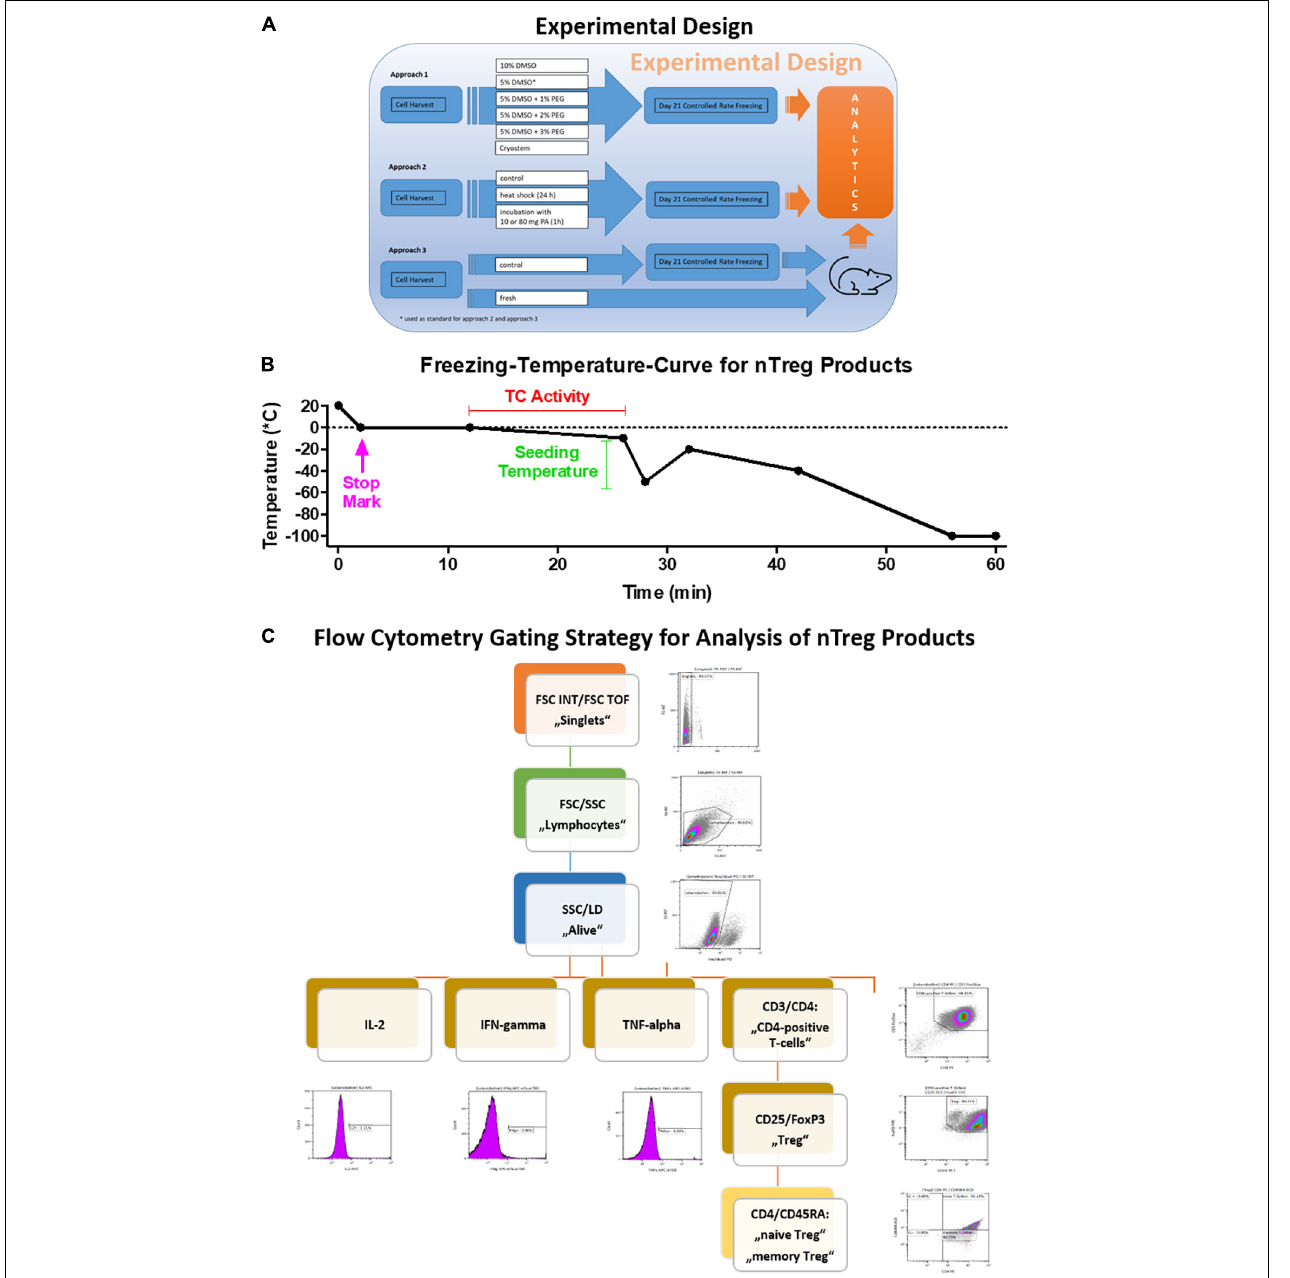
FIGURE 1 | Freezing curve and flow cytometry gating strategy. (A) Experimental design and (B) Programmed freezing curve as shown in Tables 1 , 2 [Stage Temp. ( ◦ C) Duration Heating Stop Seeding Temp. control] and (C) Gating scheme used for the analysis of the FACS data. The scheme ensures the exclusion of doublets and dead cells. It identifies lymphocytes first and uses the marker CD3 for the detection of CD4+ cells. The latter are further analyzed for their expression of the Treg relevant markers CD25 and Foxp3. The amount of cytokine producing cells is gated on all living